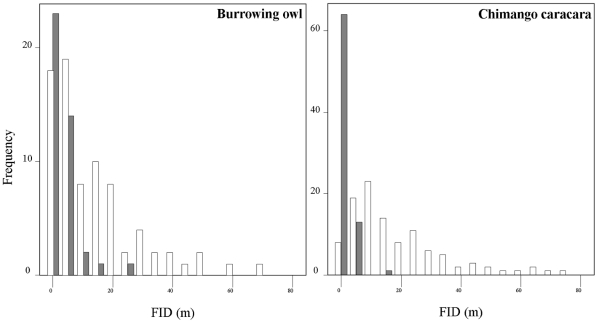
Distribution of flight initiation distances of urban (black bars) and
rural (white bars) individuals, as exemplified by the burrowing owl
Athene cunicularia (n = 119) and
the chimango caracara Milvago chimango
(n = 185).